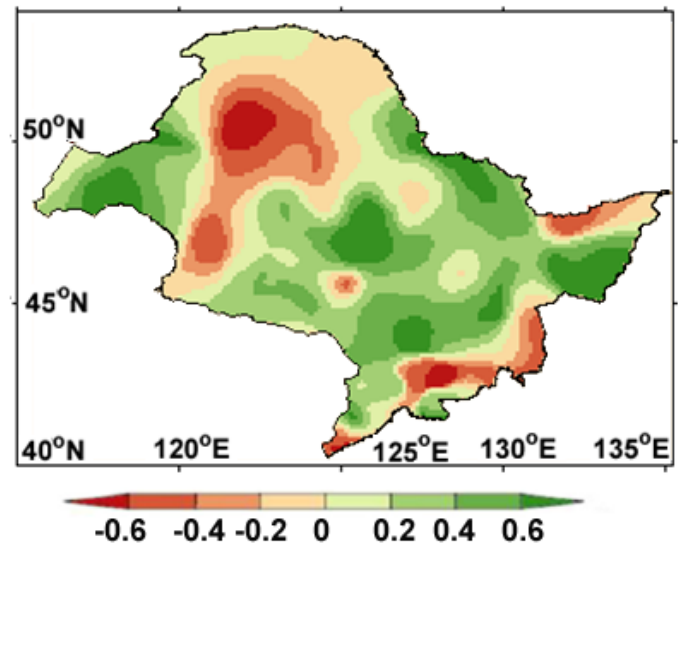
Figure 9. Maps of the correlation coefficients between annual MEI and